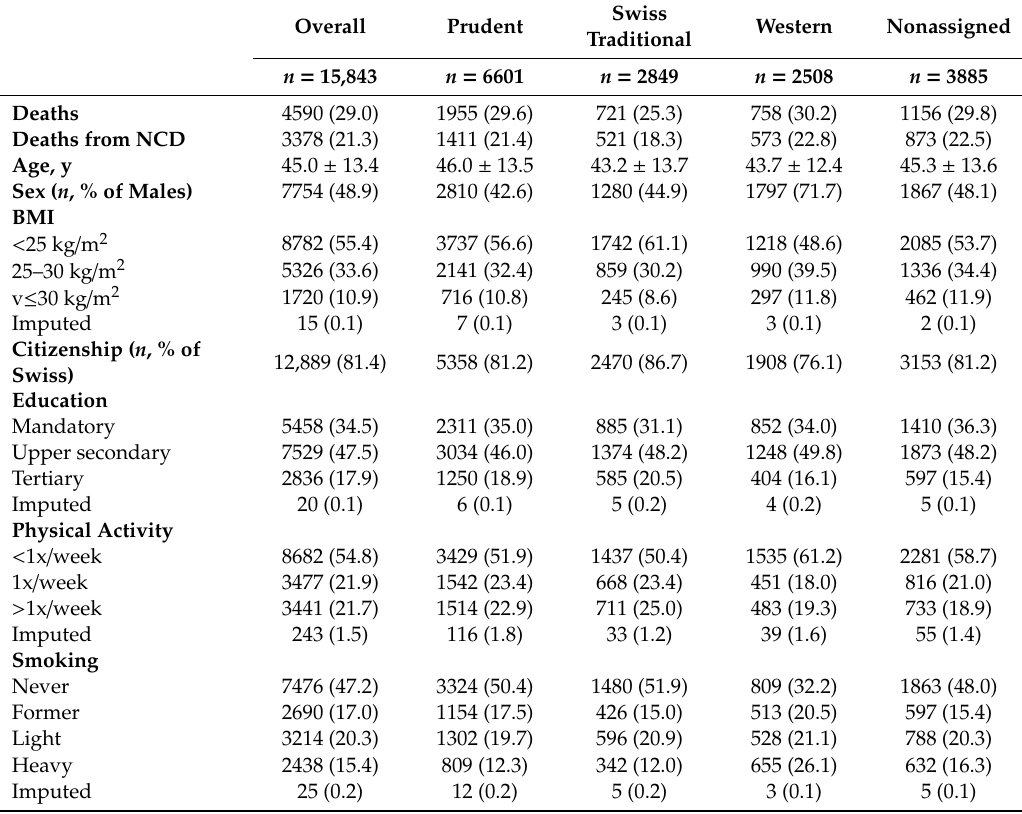
Table 1. The characteristics of the NRP–MONICA cohort participants by dietary